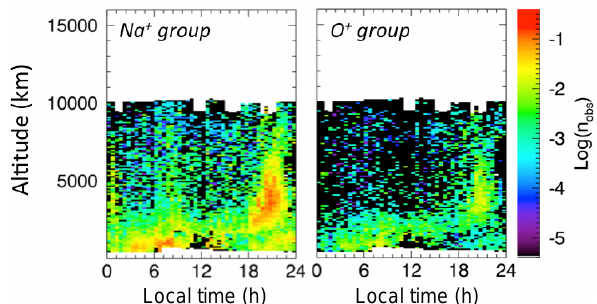
Local time (h) Local time (h) Fig. 1. Observed densities of Na + -group and O + -group ions as measured by the FIPS instrument on board MESSENGER. Den- Figure 1 sities are shown as a function of local time and altitude, and coded according to the color scale at right (adapted from Raines et al.,